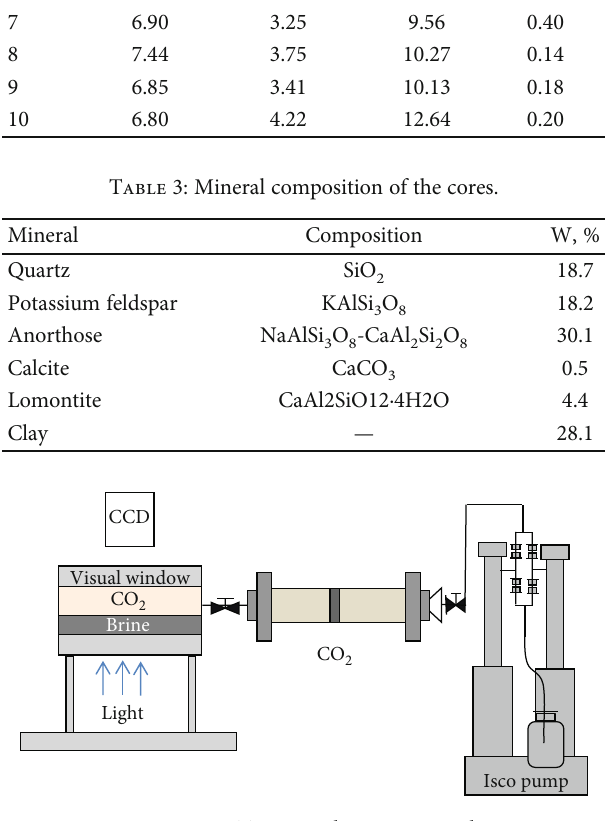
Figure 1: HTHP visual reaction